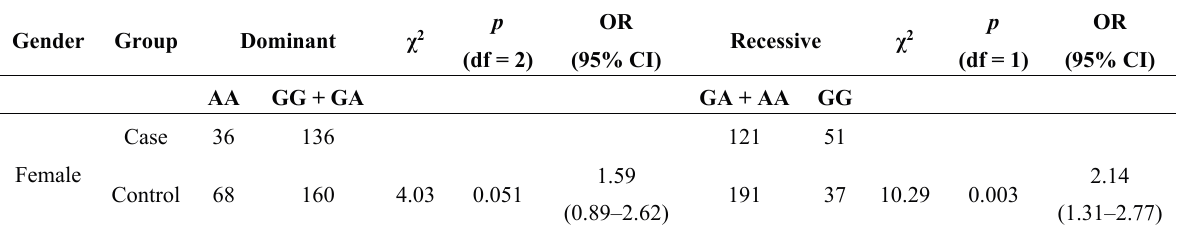
Table 3. Association between rs4977574 and CHD under the dominant and the recessive models in females a